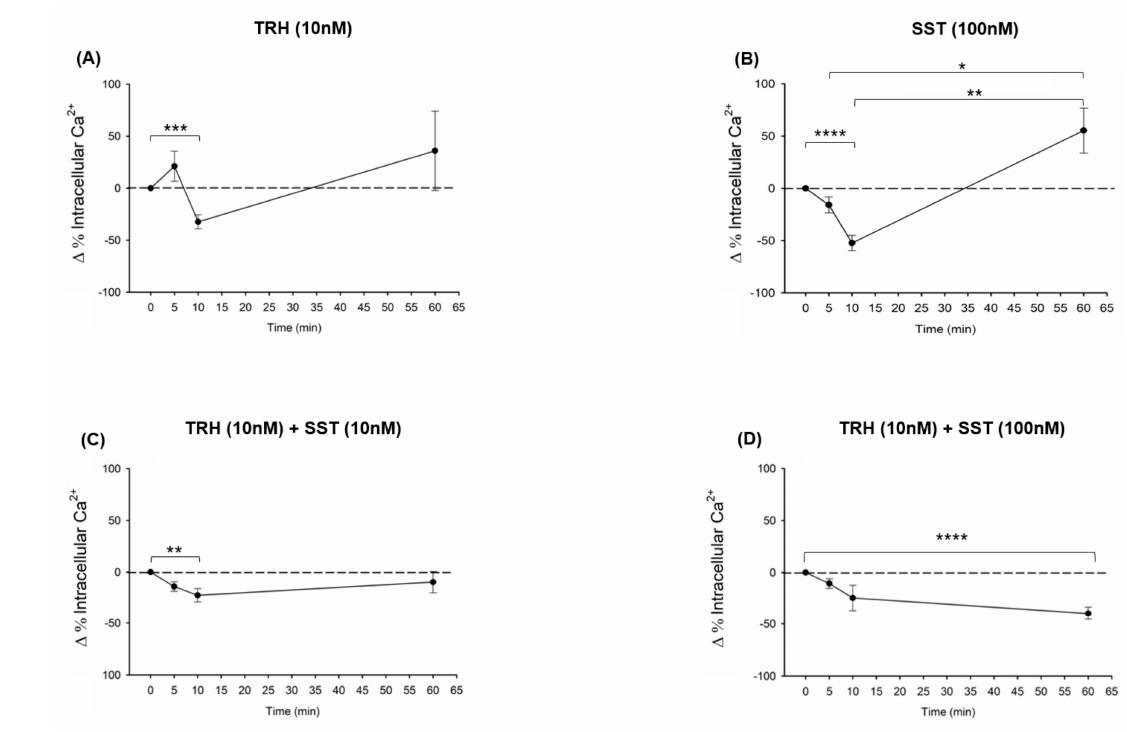
Figure 7. TRH and SST effects upon intracellular Ca 2+ levels. Intracellular calcium concentrations were measured in B-bursal cells over 5, 10, and 60 min., with the following treatments: 10 nM TRH ( A ), 100 nM SST ( B ), or the combination of both hormones [TRH 10 nM + SST 10 nM ( C ) and TRH 10 nM + SST 100 nM ( D )]. RPMI 1640 medium was used as control (0 min.). Each point represents mean ± SEM. Data was obtained from four independent experiments for the cases of TRH or SST; on the other hand, three independent experiments were used in the combination of TRH + SST. Units are expressed as a delta proportion ( Δ %) in relation to the control. Asterisks indicate differences between experimental groups, as determined by paired t test. * p < 0.05; ** p < 0.01; *** p < 0.001; **** p < 0.0001.